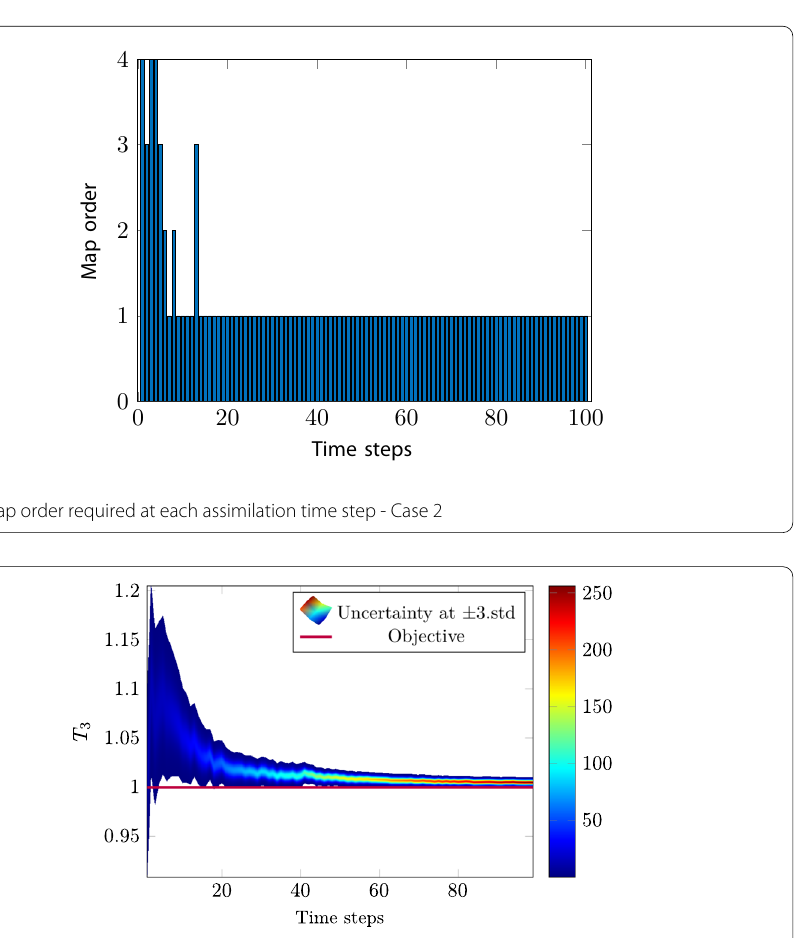
Fig. 20 the time evolution of the pdf of T 3 | t in the case of a controlled welding process.